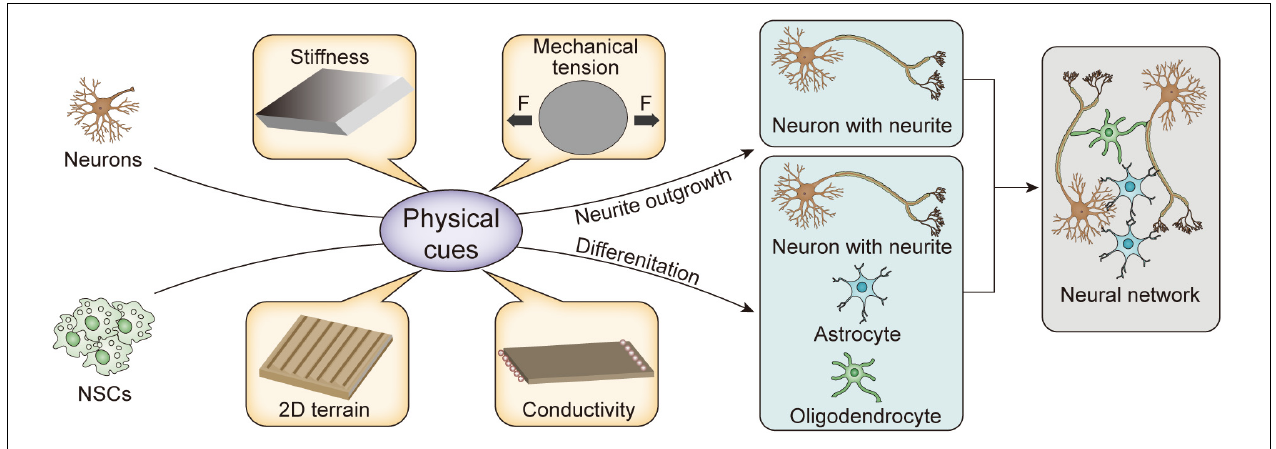
FIGURE 1 | Schematic illustration of physical cues for remodeling nerve cells.